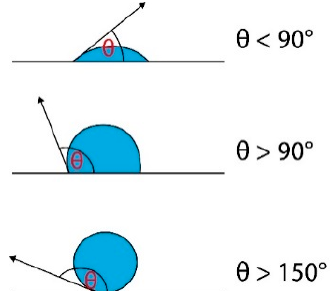
Figure 1. Different contact angles θ of a drop on a surface. If θ < 90°, the surface is called hydrophilic. Conversely, when θ > 90° the surface is hydrophobic, and when θ > 150° it is defined as superhydrophobic.